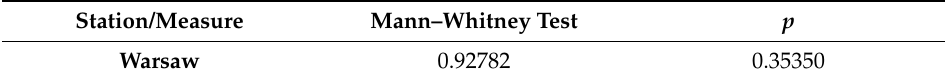
Table 9. Results of the Mann–Whitney test together with the right values of probability for Warsaw station for